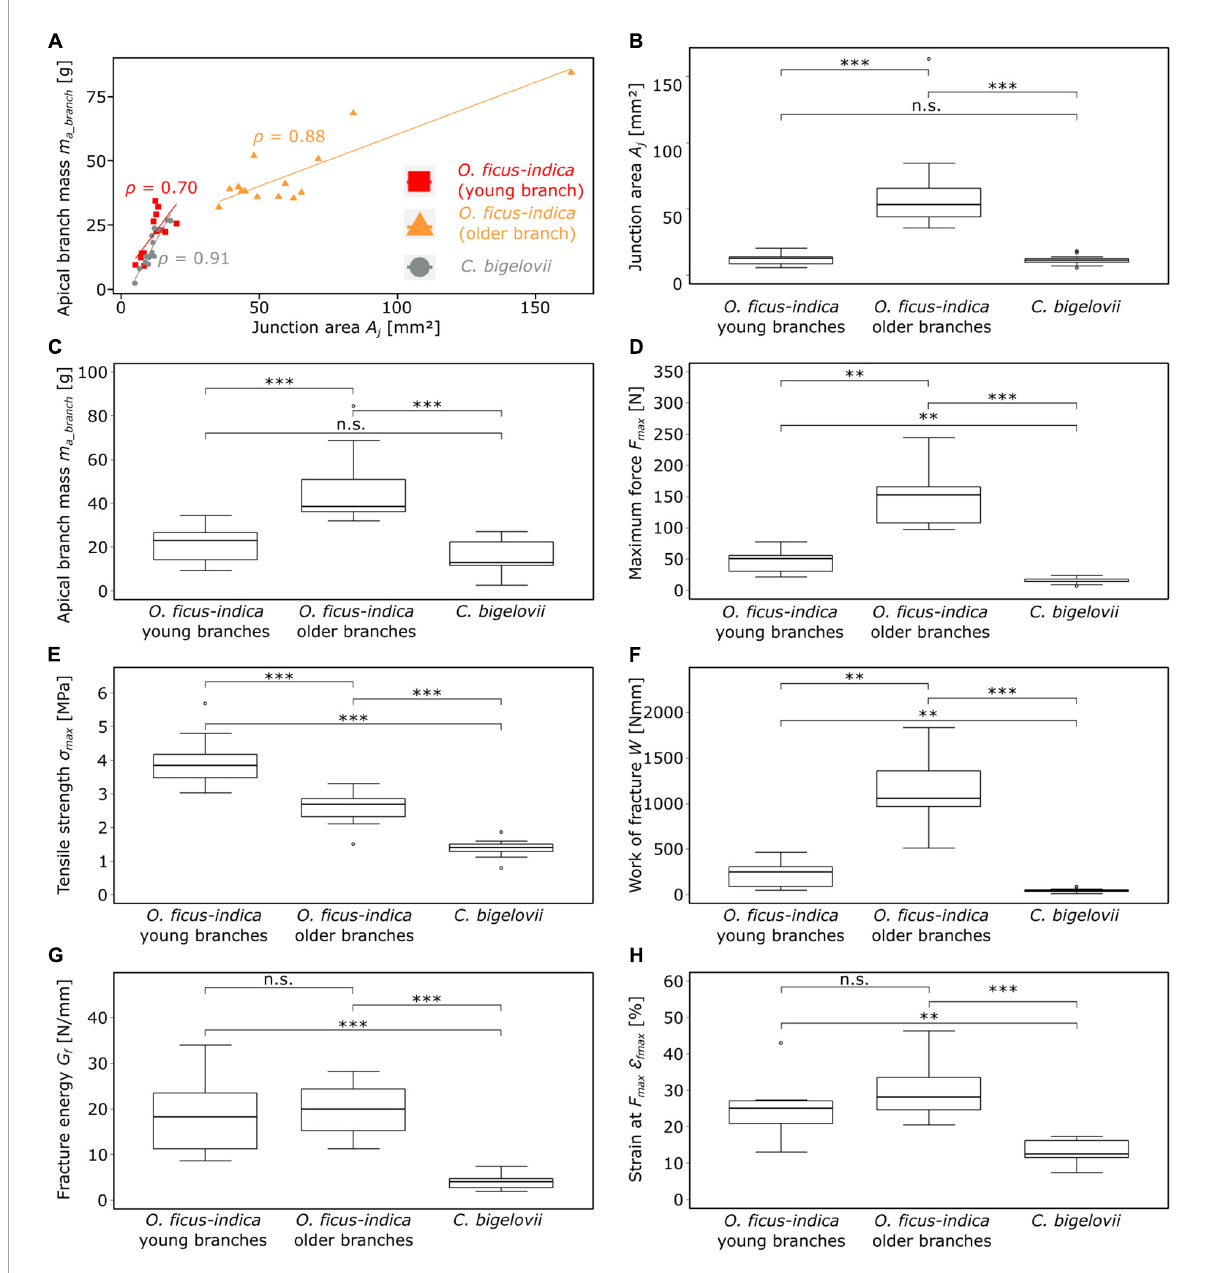
FIGURE7 Plots and statistical comparisons of various geometric, physical, and biomechanical variables of the lateral branch-branch junctions of Opuntia ficus-indica (with distinction between samples with young and older lateral branches) and Cylindropuntia bigelovii . (A) Scatter plot of the apical branch mass against the junction area. The linear regression line and the corresponding Pearson’s ρ -value are indicated for each of the three groups (red = young lateral O. ficus-indica branches, orange = older lateral O. ficus-indica branches, gray = C. bigelovii ). Box plots of the (B) junction area, (C) apical branch mass, and (D–H) several fracture variables calculated from the force-displacement and stress-strain curves of the tensile tests until failure are presented. The sample size for all the presented variables was 14 for both groups of O. ficus-indica and 15 for C. bigelovii . Levels of significance between the groups are marked as follows: p ≥ 0.05: not significant (n.s.); 0.01 > p ≥ 0.001: very significant ( ∗∗ ); 0.001 > p : highly significant ( ∗∗∗